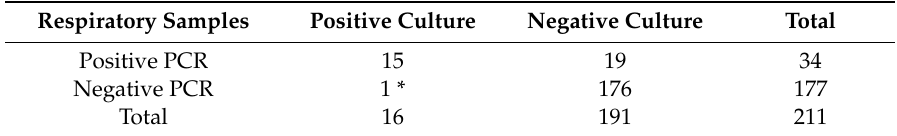
Table 4. Concordance of PCR and cultures on respiratory samples ( n = 211) to detect the presence of Aspergillus .